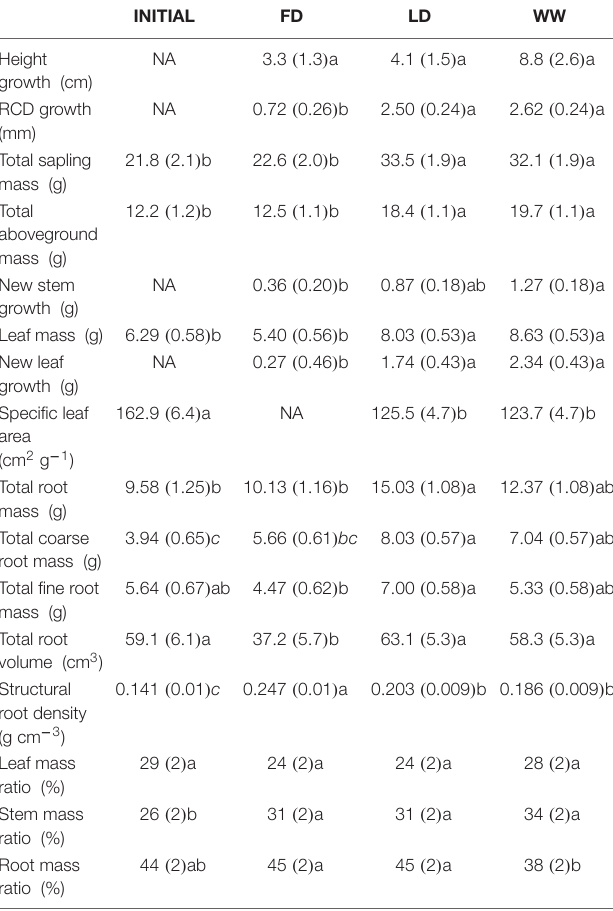
TABLE 1 | Estimated marginal means ( ± 1 standard error) of aboveground and belowground variables: height growth (cm), root collar diameter (RCD) growth (mm), total sapling mass (g), total aboveground mass (g), new stem growth (g), leaf mass (g), new leaf growth (g), specific leaf area (cm 2 g − 1 ), total root mass (g), total coarse root mass (g), total fine root mass (g), total root volume (cm 3 ), structural root density (g cm − 3 ), leaf mass ratio (%), stem mass ratio (%) and root mass ratio (%) prior to (INITIAL) and after three watering treatments (FD, full drought; LD, localized drought; WW,